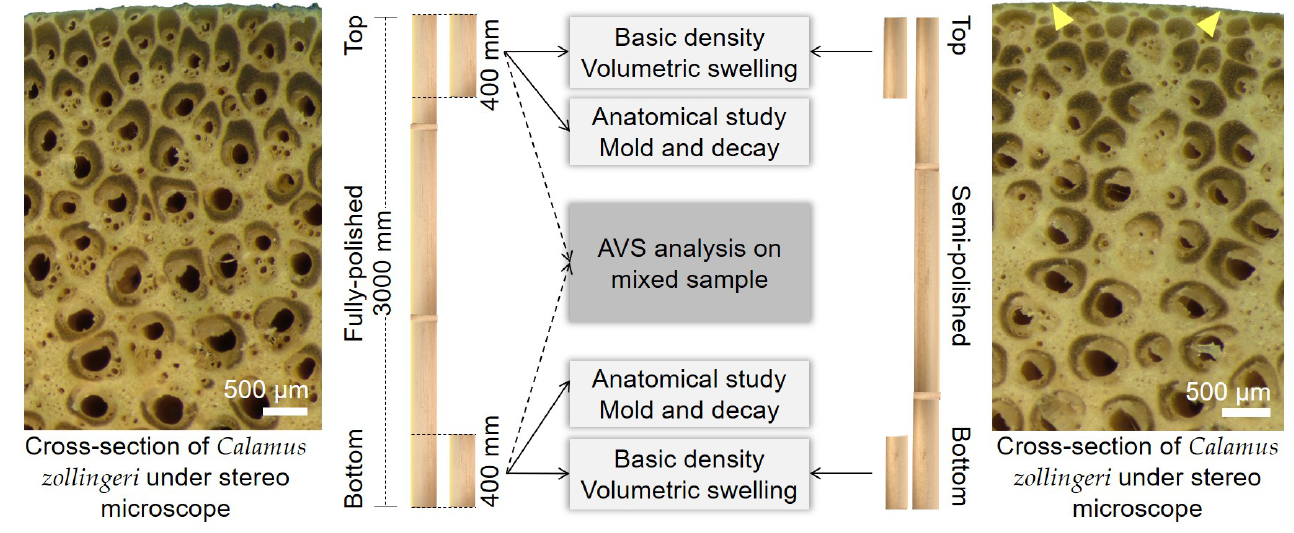
Figure 1. Schematic diagram of sample preparation and analyses. AVS: automated vapor sorption. Arrowheads in semi-polished sample show some cortex tissues. Cane length and diameter are not true to scale.